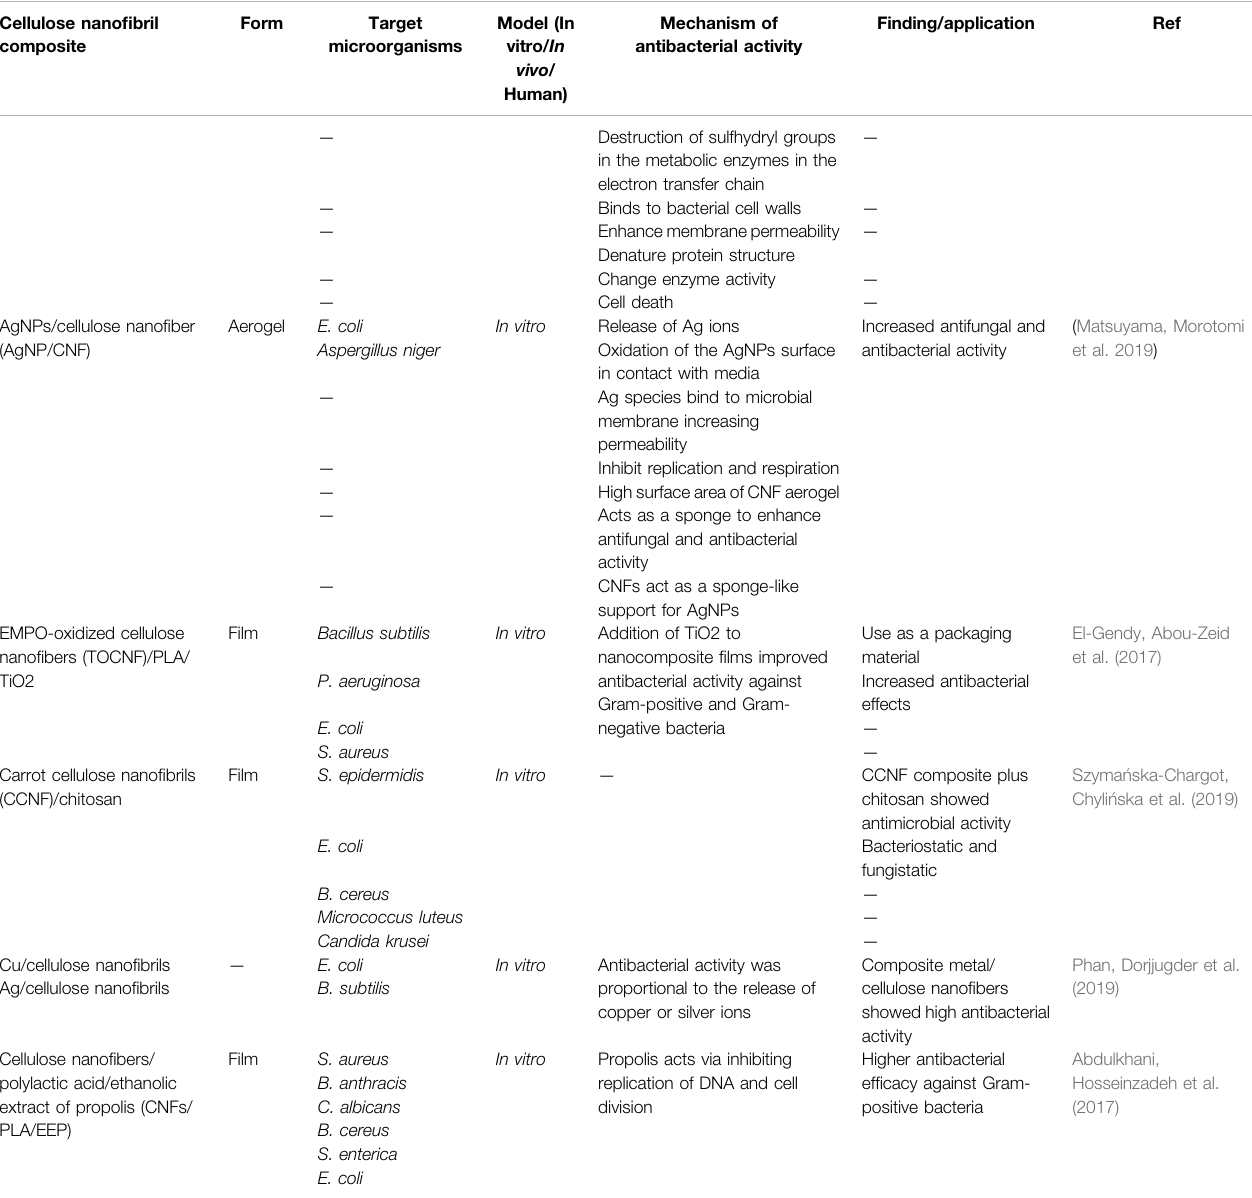
TABLE 1 | ( Continued ) Various cellulose-based nano fi brils used against bacterial